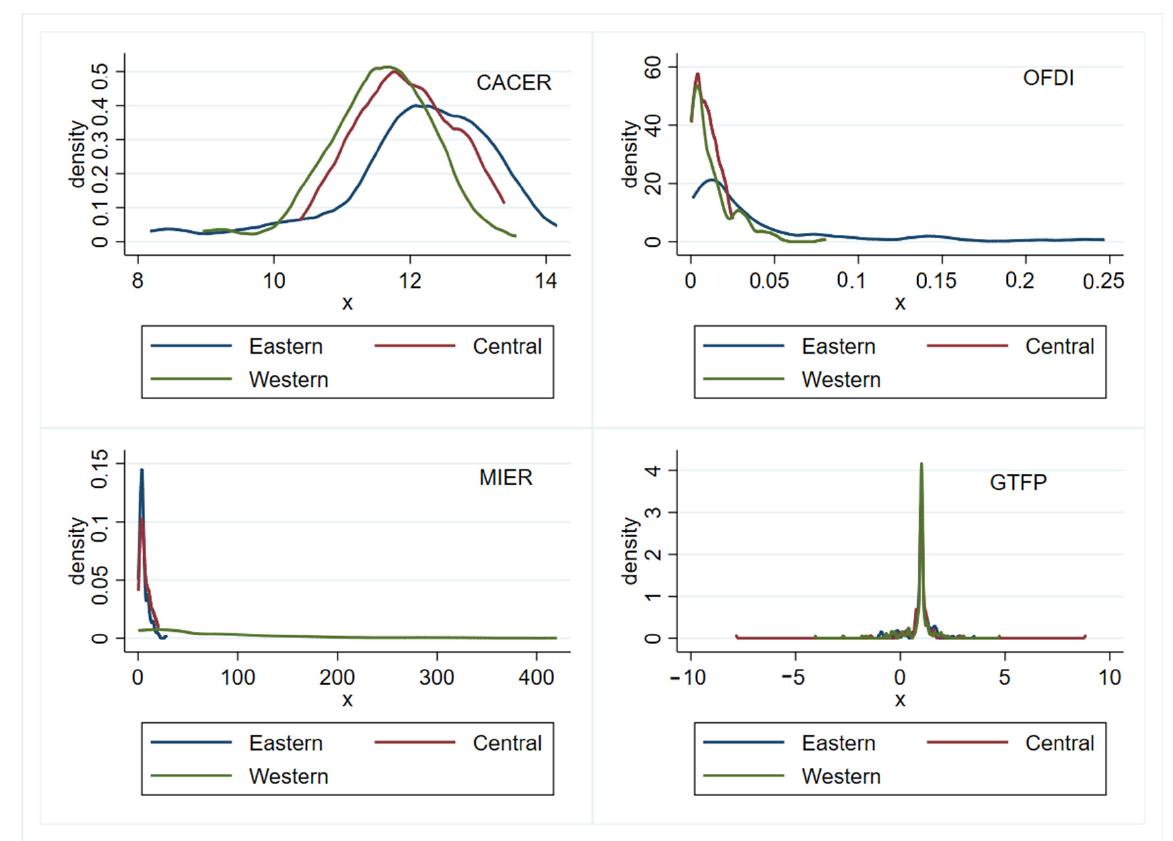
Figure 4. The kernel density curves of CACER, MIER, OFDI, and GTFP in different regions.